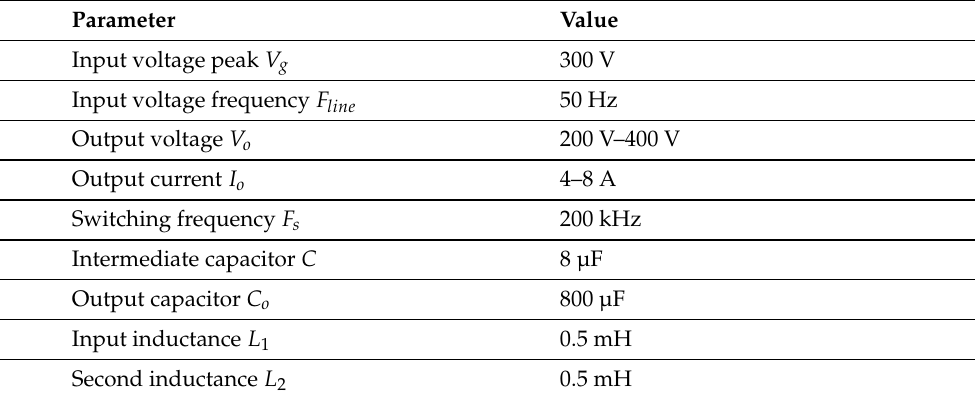
Table 2. Converter